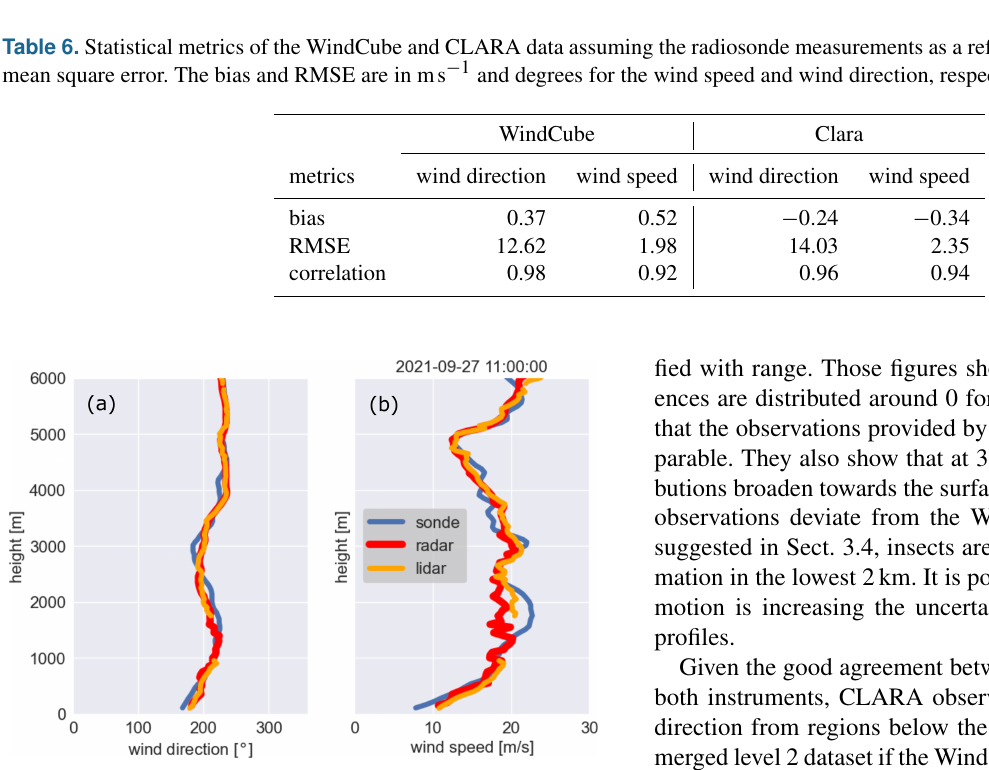
Figure 9. Profiles of wind direction (panel a ) and wind speed (panel b ) from 27 September 2021 at 11:00UTC. The blue, red, and or- ange lines indicate the radiosonde, CLARA, and WindCube obser- vations,